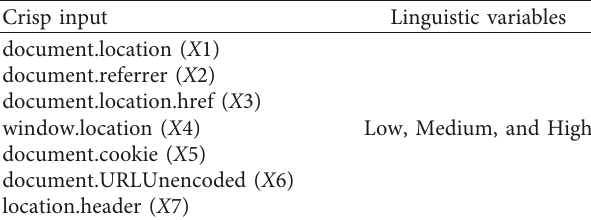
Table 1: Crisp input and linguistic variables.